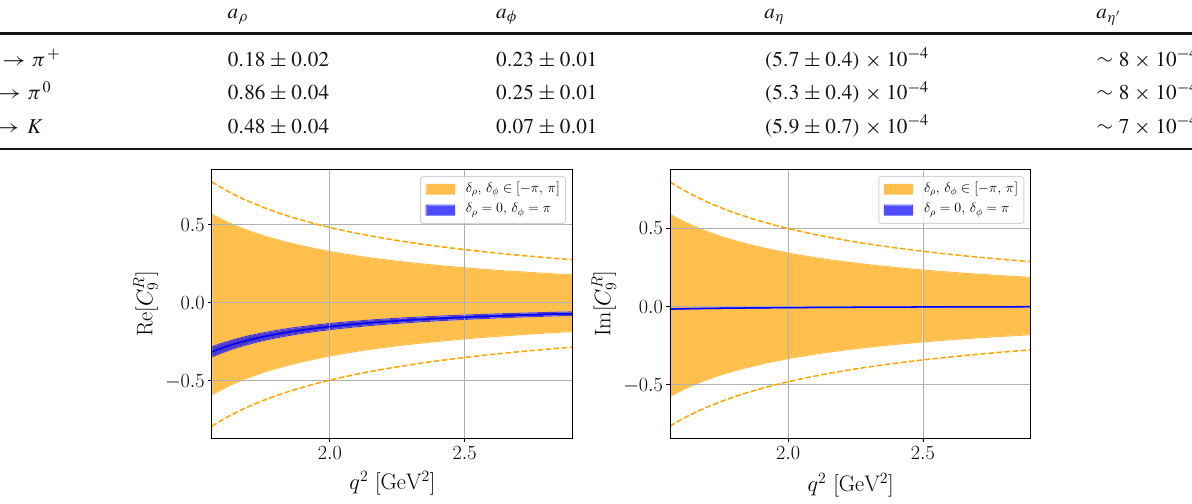
[− π, + π ] , whereas the smaller blue bands correspond to fixed strong Fig. 1 Resonance contributions to the real part (plot to the left) and the imaginary part (plot to the right) of C R in the high q 2 –region using phases δ ρ = 0 ,δ φ = π . Additional uncertainties arise from a ρ , a φ , and 9 the D + → π + parameters from Table 1. The wider yellow bands cor- are included in the plots. The dashed curves illustrate the uncertainties in the case of D 0 → π 0 parameters respond to the uncertainties from strong phases δ ρ ,δ φ varied within (cid:14) q 2 –region ( q 2 ≥ 1 . 25 GeV) for D → πμ + μ −